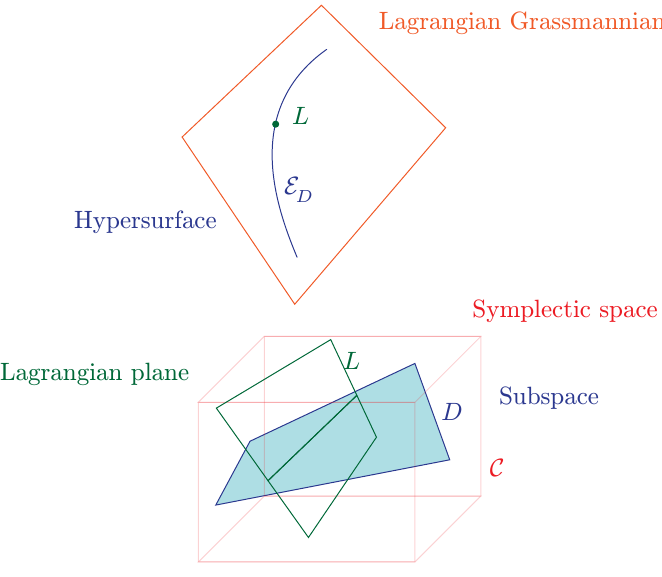
Fig. 10. Selecting only those Lagrangian planes that are non–transversal to D , one gets a hypersurface in E D in the Lagrangian